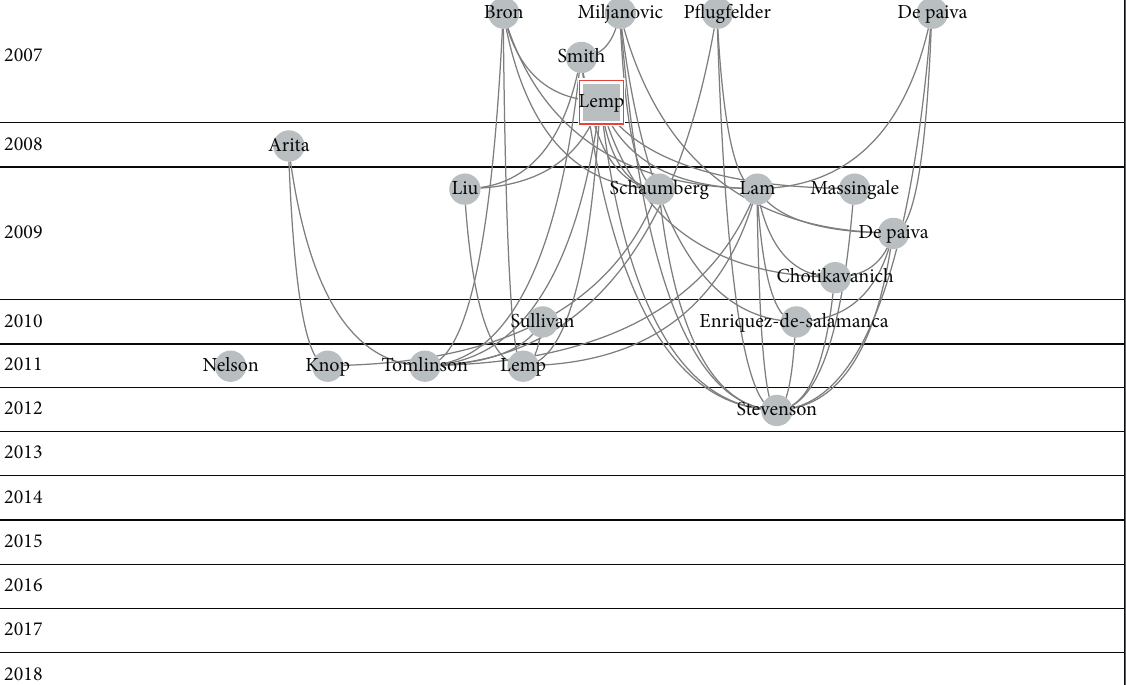
Figure 1: Dry eye citation network graph from CitNetExplorer.